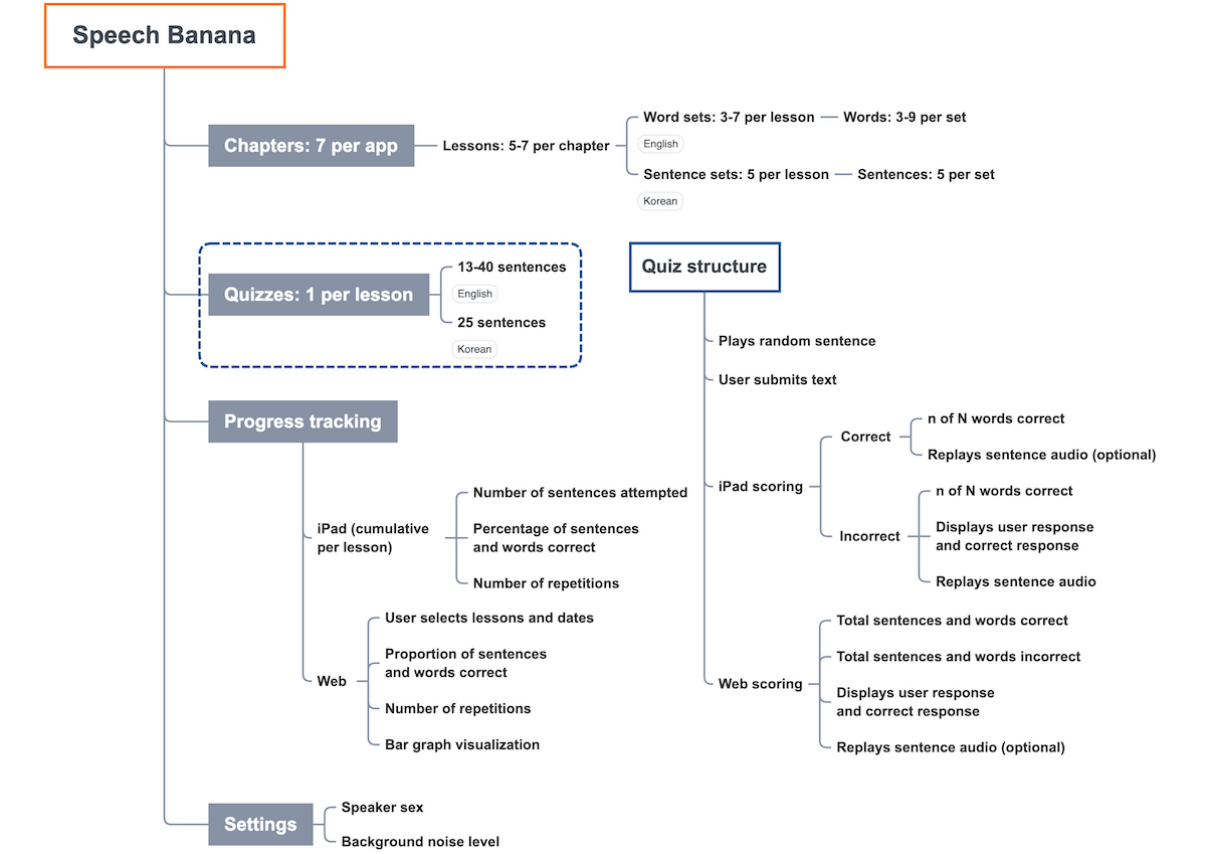
Figure 2. Lesson and quiz structure of the Speech Banana